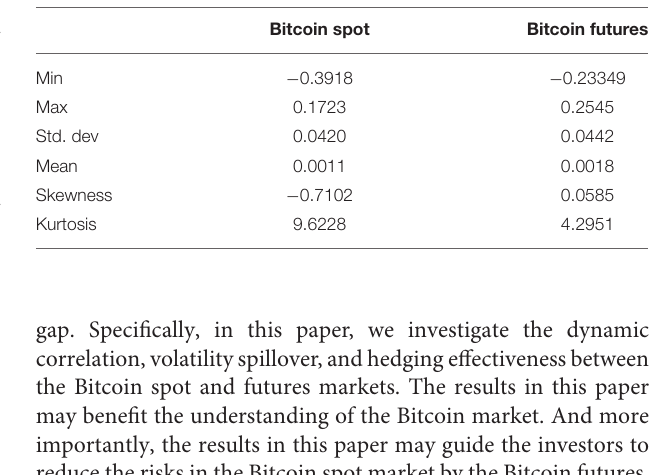
TABLE 1 | Basic descriptive statistics of Bitcoin spot and